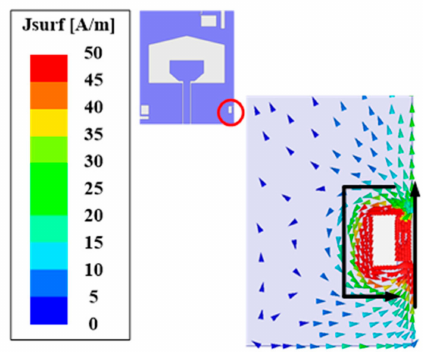
Figure 11. Simulated surface distribution of the NB antenna at the resonant frequency of 9.5